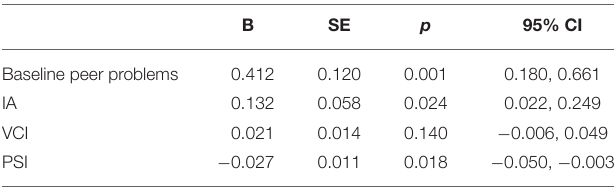
TABLE 3 | Baseline peer problems, inattention, and intellectual function as predictors of preadolescent peer